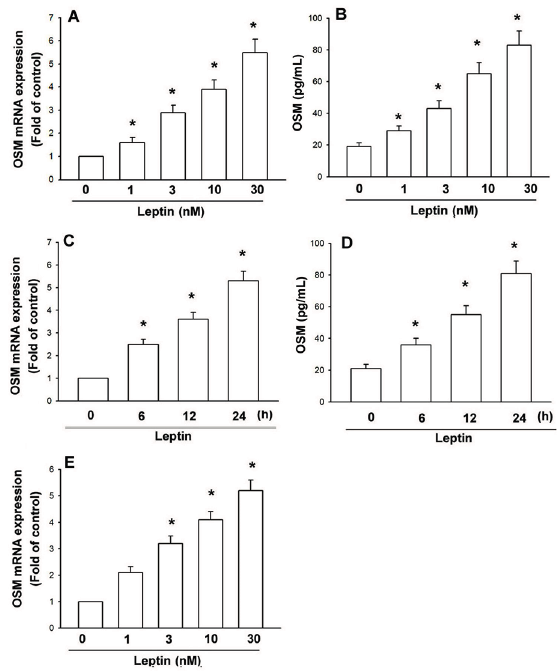
Figure 1. Leptin induces OSM expression in human osteoblasts. ( A , B ) Osteoblasts were incubated with various concentrations of leptin for 24 h. Media and total RNA were collected, and the expression of OSM was examined by qPCR and ELISA assay ( n = 5); ( C , D ) Osteoblasts were incubated with leptin (30 nM) for 6, 12 or 24 h. Media and total RNA were collected, and the expression of OSM was examined by the qPCR and ELISA assay ( n = 4); ( E ) Osteoblasts from OA patients were incubated with various concentrations of leptin for 24 h. Total RNA was collected, and the expression of OSM was examined by qPCR ( n = 3). The results are expressed as the mean ± SEM; * p < 0.05 as compared with the basal level.